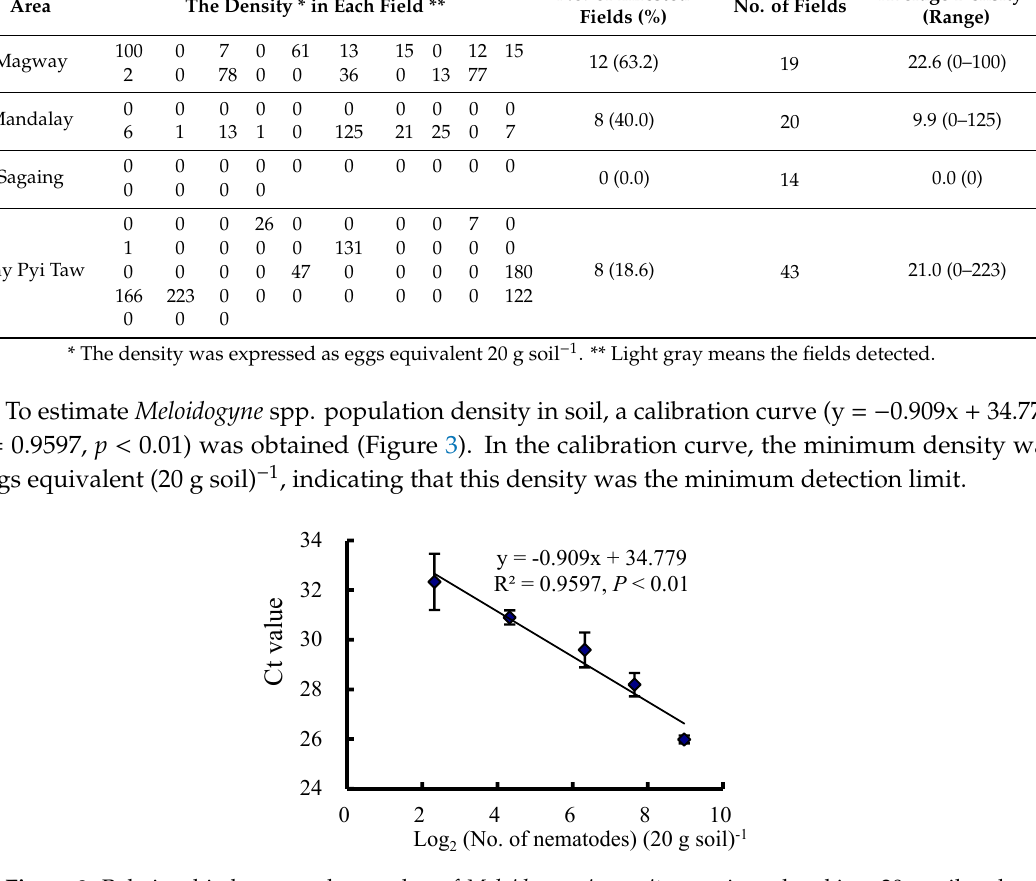
Average Density * No. of Infested No. of Fields (Range) Fields (%)